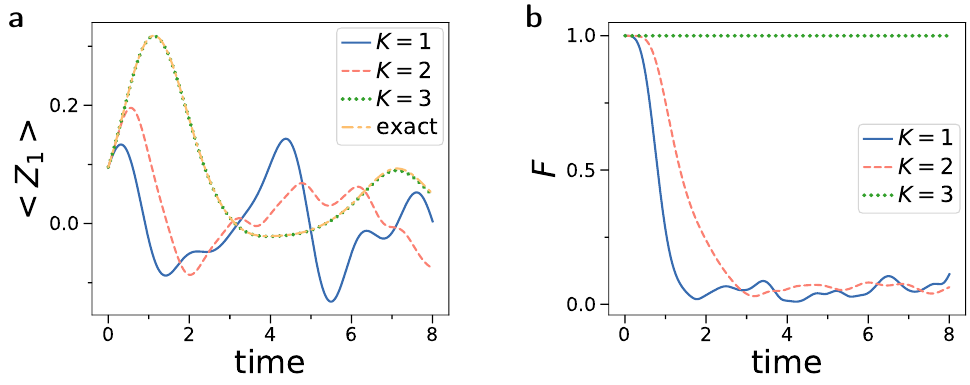
Figure 3: Time evolution of TQS on a 8 qubit state, with Hamiltonian H , simulated 8 on a classical computer, with a random initial state. The initial state was generated with 3 successive layers of U rotations with randomized parameters on each qubit, 3 followed by CNOT / entangling gates. This is further described in Appendix A.